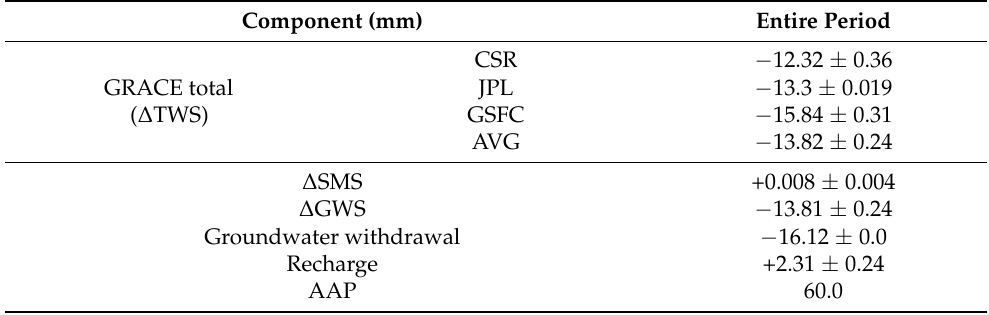
Table 1. ∆ TWS parts (mm/yr − 1 ) for the entire study region with a confidence level of 95%.